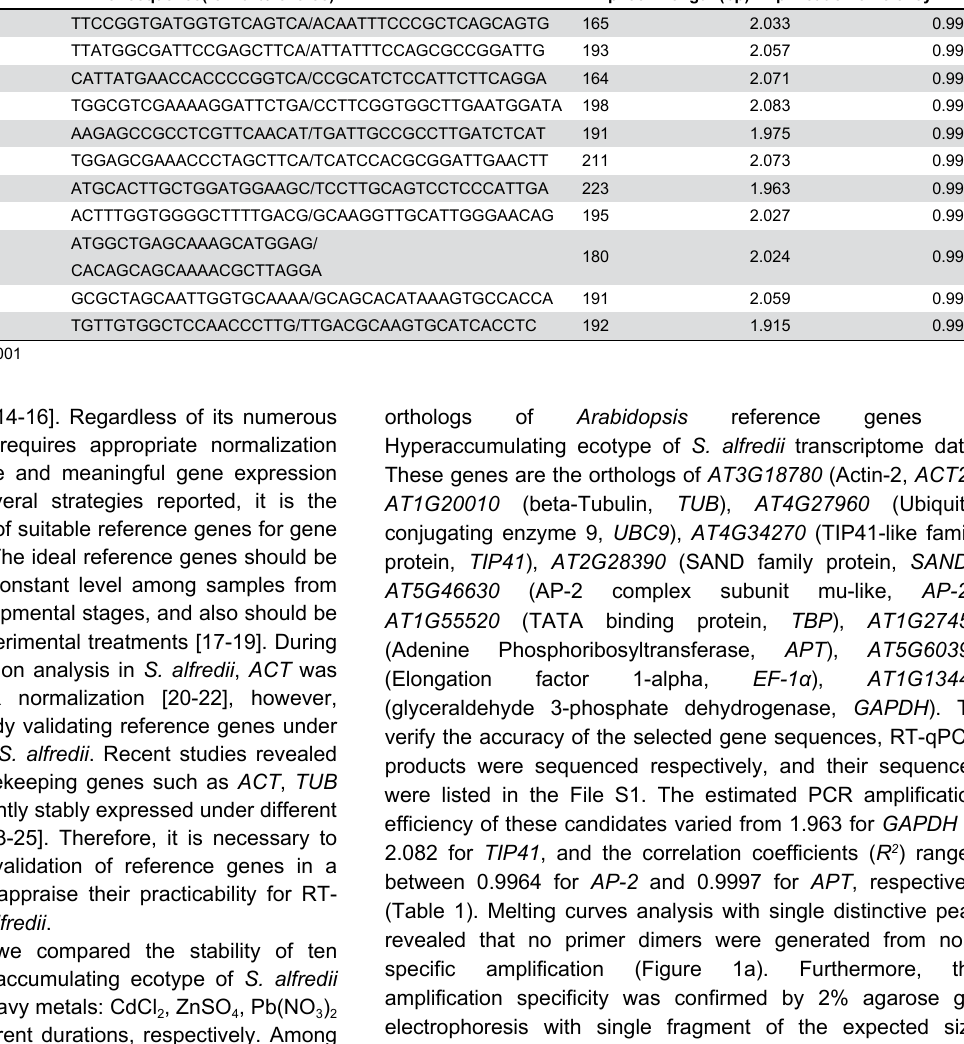
SymbolGeneBank Accession Gene nmuber Primer